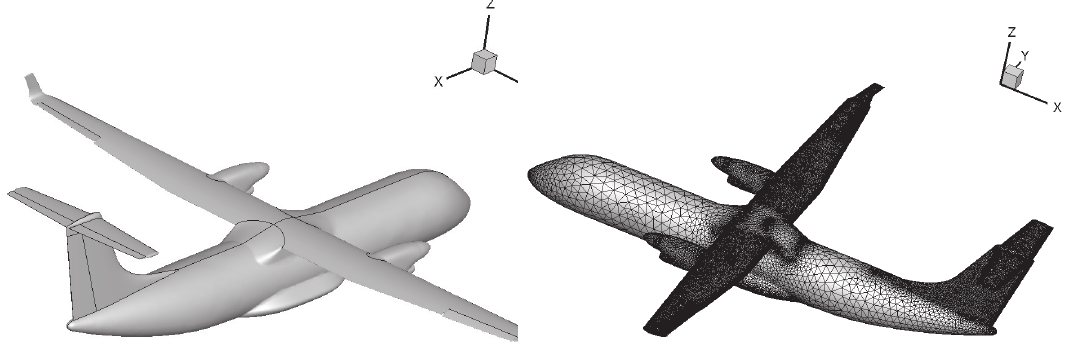
Figure 5. Perspective views of CAD model ( left ), and surface mesh ( right ), for the whole aircraft with deflected ailerons.